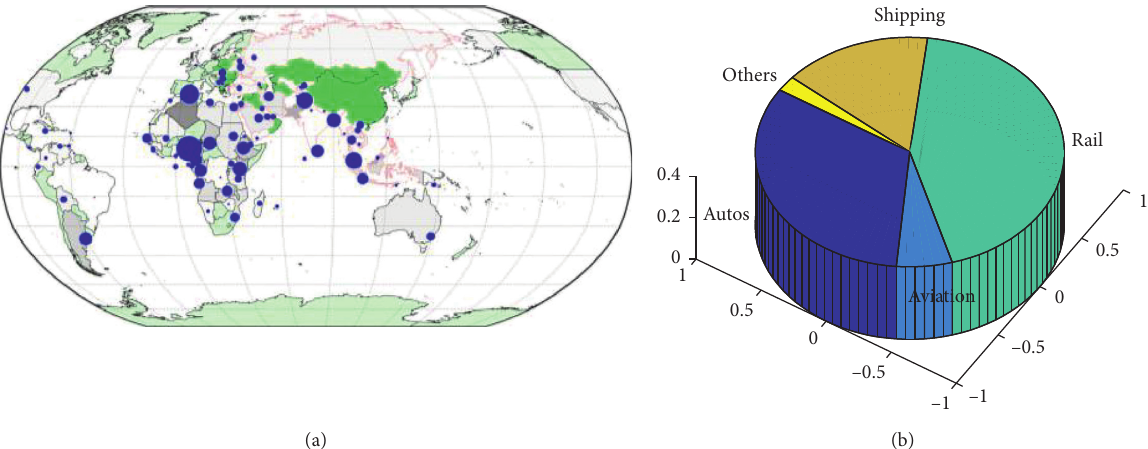
Figure 18: China’s overseas transport construction projects (2005–2017) (No. 7): (a) spatial distribution; (b) sector distribution.